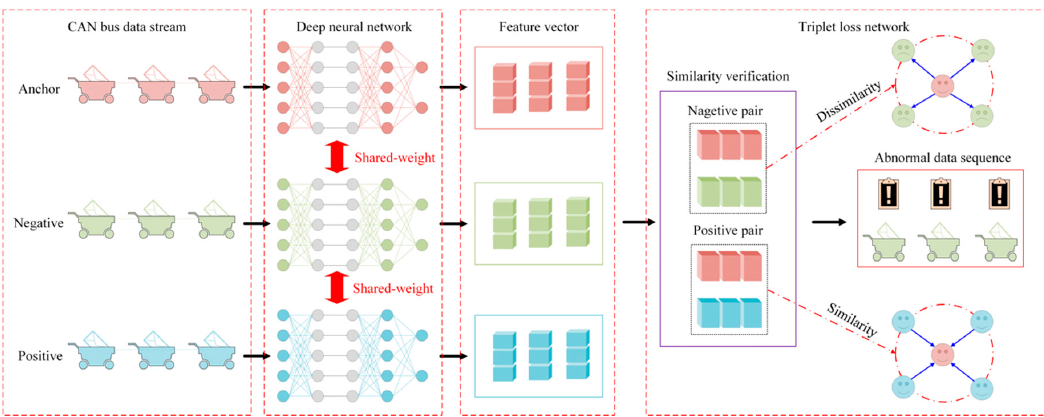
Figure 2. The full pipeline of the in-vehicle CAN anomaly detection system. The anchor, negative and positive represents annotated data, abnormal data and normal data, respectively. The aim of the proposed system is to find out the positive data.